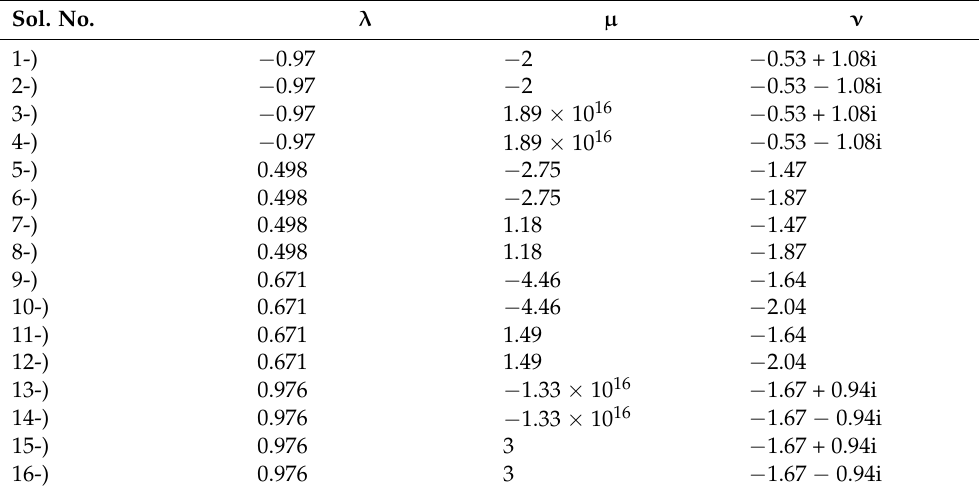
Table 8. ( λ , µ , ν ) solutions.